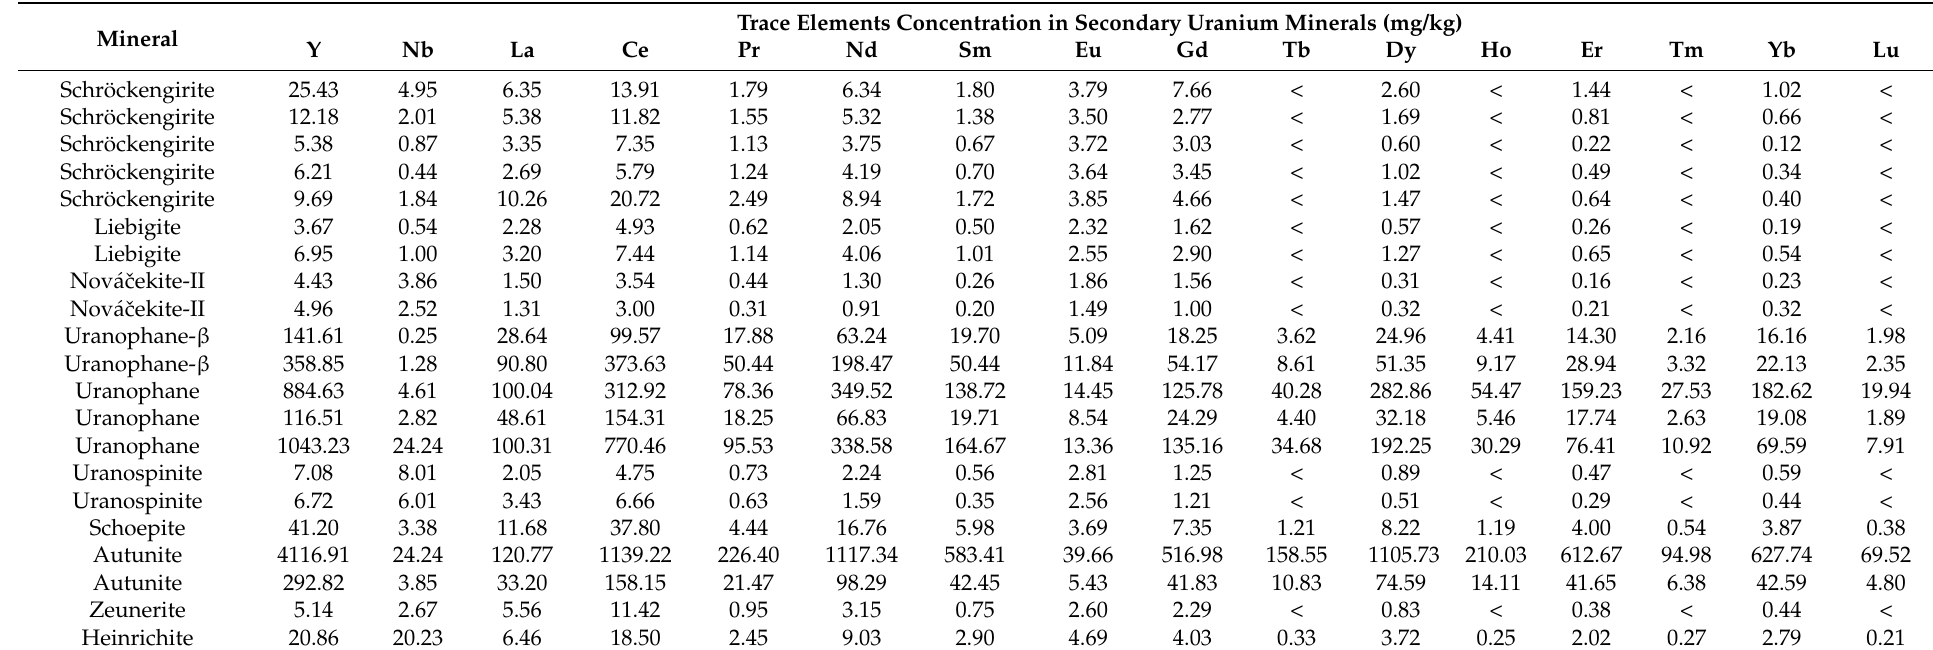
Table 10. Trace element concentrations in secondary uranium minerals from Podg ó rze